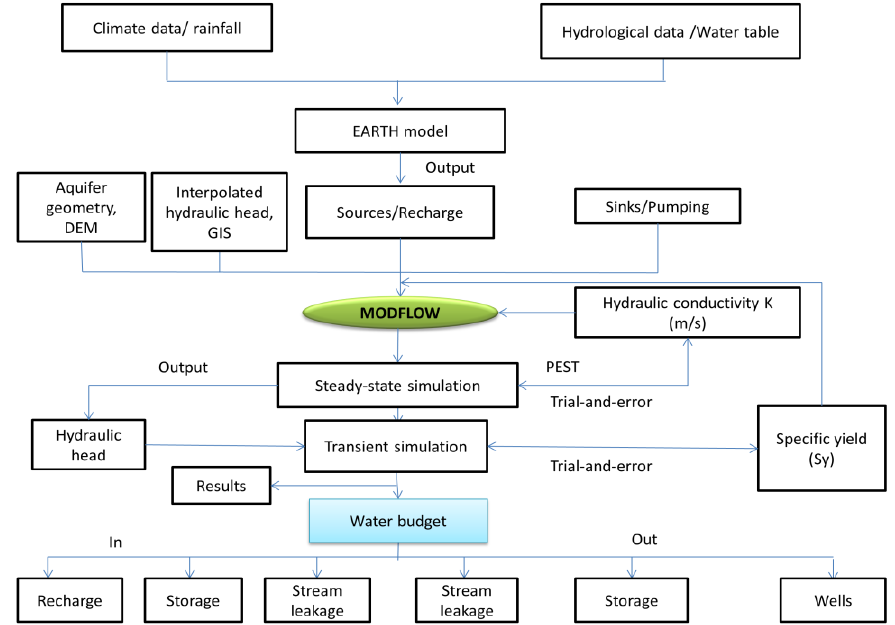
Figure 4. Methodology and data used in this study.